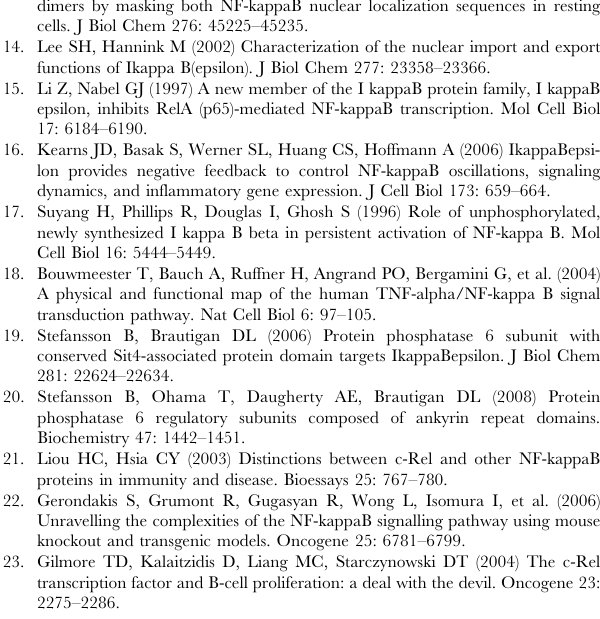
Figure S3 Attenuation of DNA-binding for AP-1 proteins and NFAT2 in TNF-treated cells. Control and TNF-treated